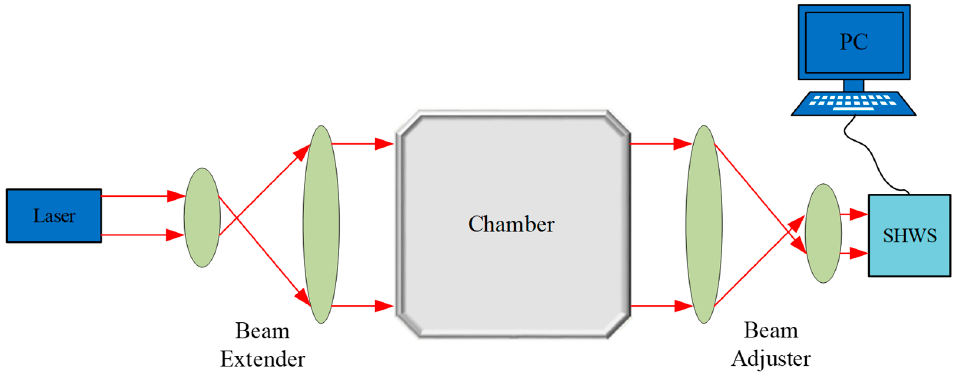
Figure 6. Schematic sketch of wavefront phase variance method.